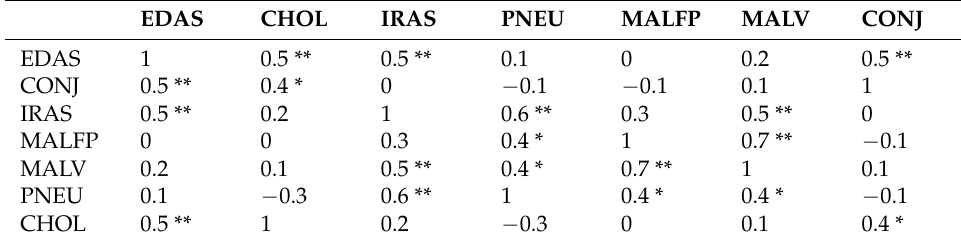
Table A3. Correlations between disease variables.